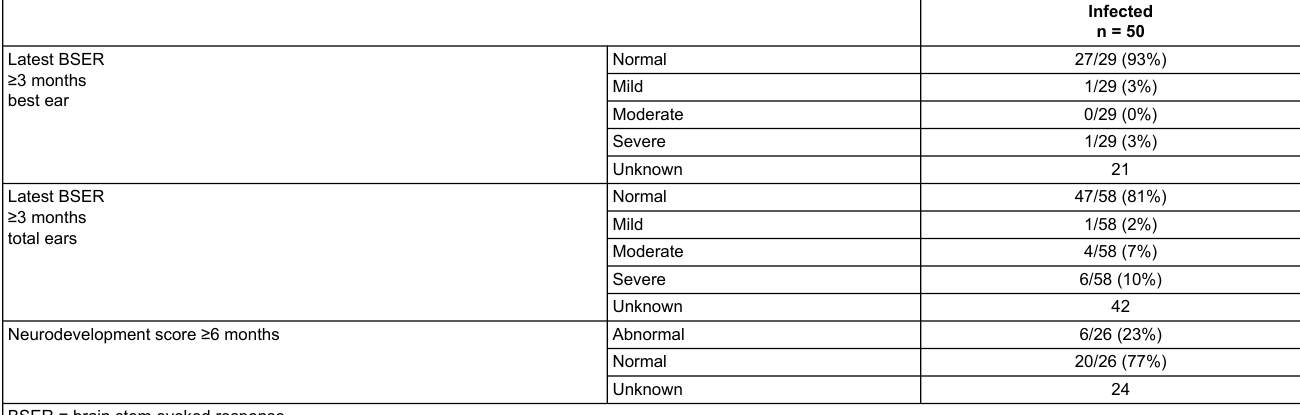
Table S2: Audiological and neurodevelopmental outcome at 3 months of age and onwards of all newborns with congenital cytomegalovirus